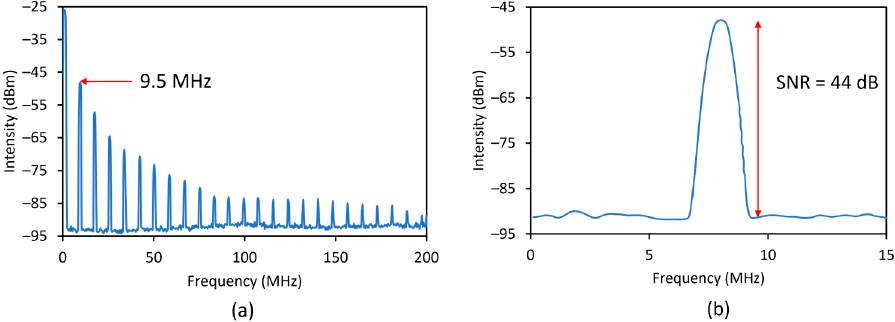
Figure 6. RF spectrum of the mode-locked YDFL: ( a ) radio frequency showing the harmonics of a pulse and ( b ) SNR measurement of 44 dB at a fundamental frequency. pulse and ( b ) SNR measurement of 44 dB at a fundamental